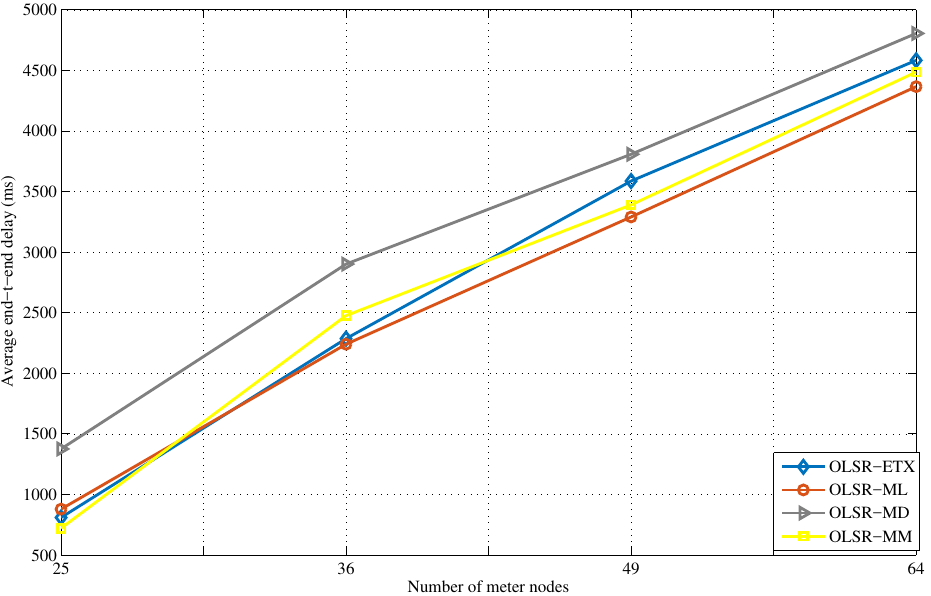
Figure 14. Average end-to-end delay for SG application on grid clusters with a central placement of the data concentrator.